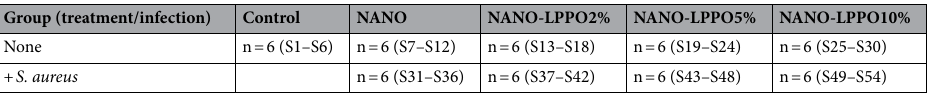
Table 2. Allocation of mice (n = 54) in treatment groups. NANO: Polycaprolactone-based nanofiber/wound dressing; LPPO: lippophosphonoxin